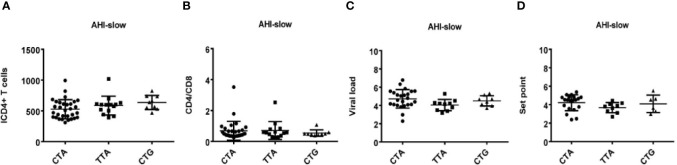
Relationship between haplotypes (CTA/TTA/CTG) and clinical indexes in AHI patients with slow progression. (A–D) There are four clinical parameters including, ICD4 (initial CD4 T cells) (A), CD4/CD8 (the ratio of CD4 versus CD8 T cells) (B), viral load (C) and set point (D). The y axis represents the values of these four clinical parameters respectively. In x axis, there are three AHI–slow patient groups with TLR7 CTA/TTA/CTG haplotype. Each dot represents an MSM individual, (●) represents individuals with TLR7 CTA haplotype. (■) represents individuals with TLR7 TTA haplotype. (▲) represents individuals with TLR7 CTG haplotype.